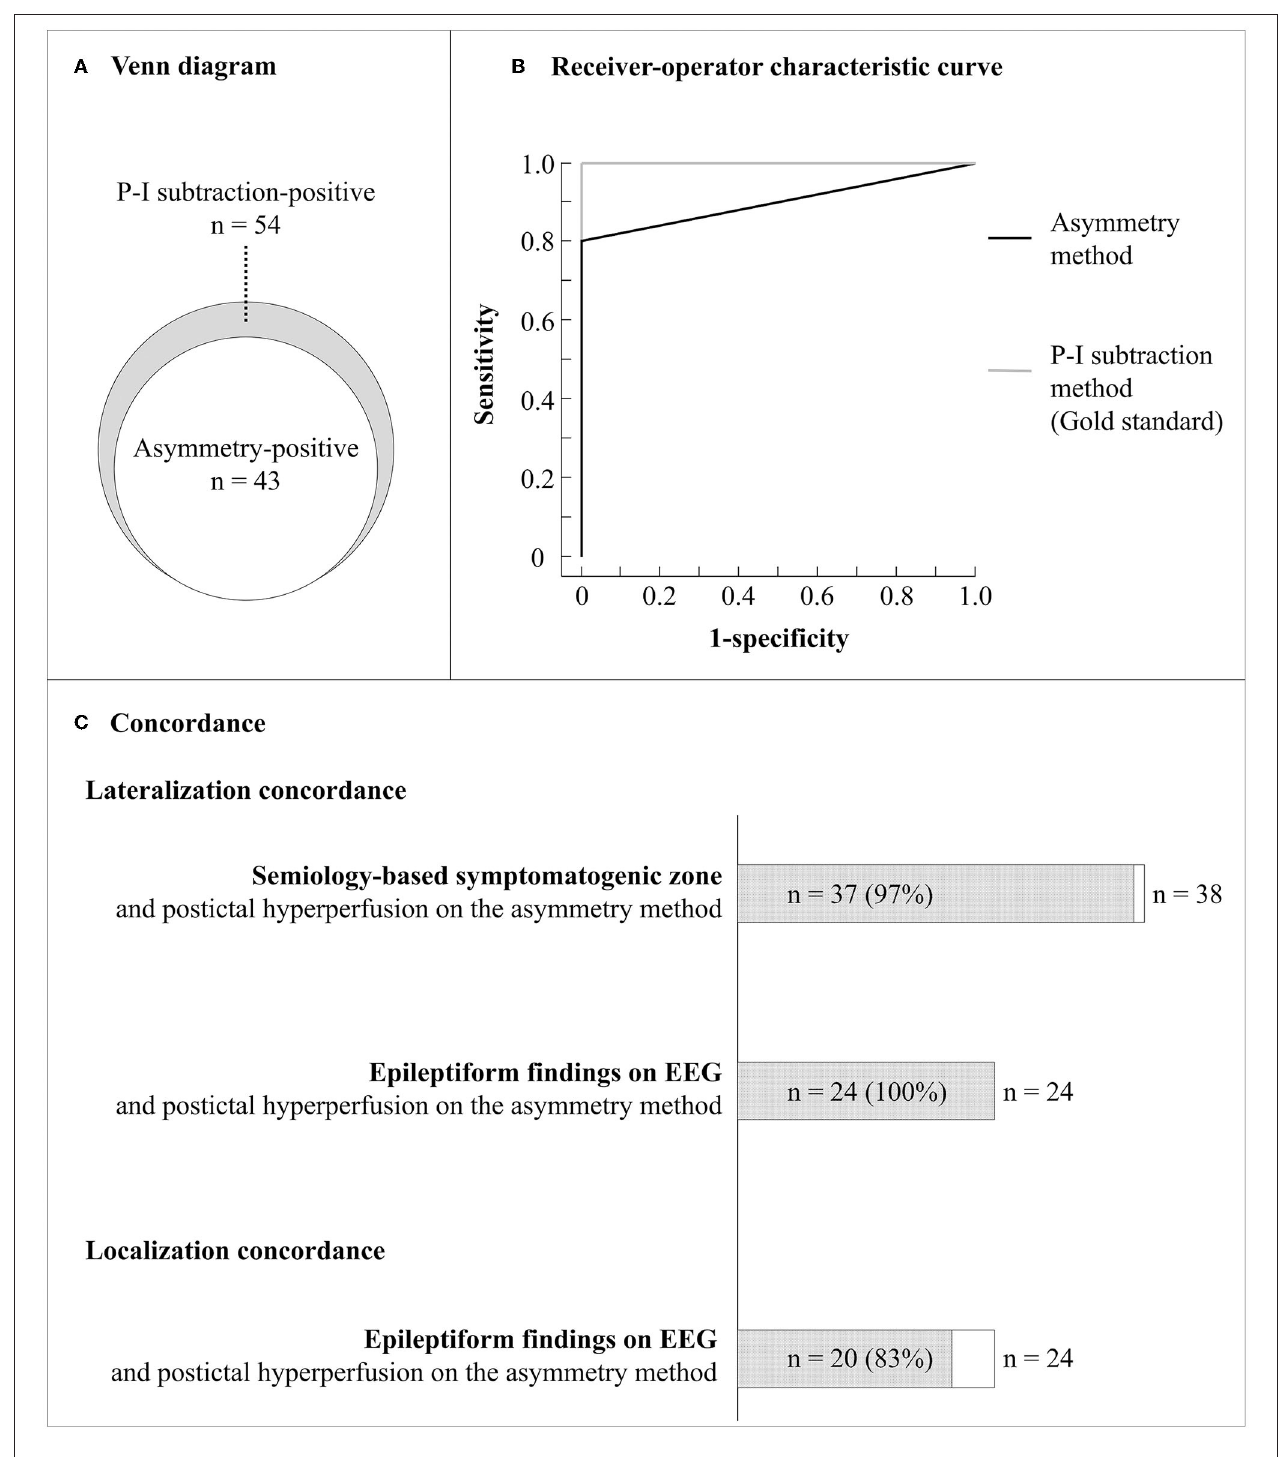
FIGURE 3 | Diagnostic accuracy and lateralization concordance with other clinical findings of the asymmetry method. (A) Venn diagram for the relationships between the patients with positive results on the asymmetry and P-I subtraction methods. (B) Receiver operating characteristic curves for the asymmetry and P-I subtraction methods. (C) Lateralization and localization concordance between clinical findings. Semiology-based symptomatogenic zone was identified in the same hemisphere in 37 of 38 patients with lateralizing signs (97%). Epileptiform findings were detected on EEG in 24 of the 43 patients and observed in the same hemisphere in 24 of the 24 patients (100%) and in the concordant regions in 20 of the 24 patients (83%). EEG, electroencephalography; P-I, postictal-interictal.